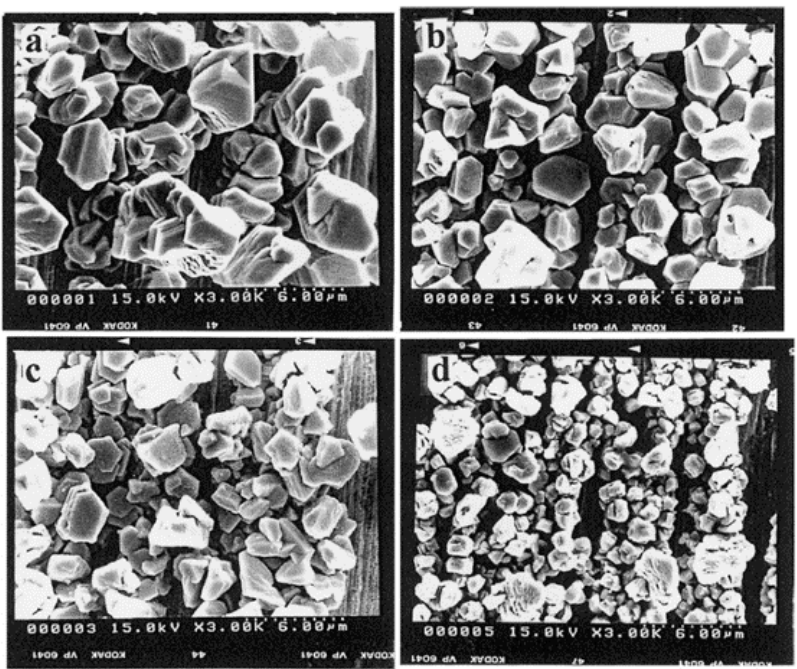
Figure 7. SEM micrographs of cadmium electrodeposits on tungsten wires that were produced in a 37.9 mM Cd(II) in basic EMI ∙ Cl ∙ BF 4 melt at 30°C and the following applied potentials, ( a ) − 1.1; ( b ) − 1.12; ( c ) − 1.14; and ( d ) − 1.2 V. [Reproduction with permission from Chen, P.Y.; Sun, I.W.,